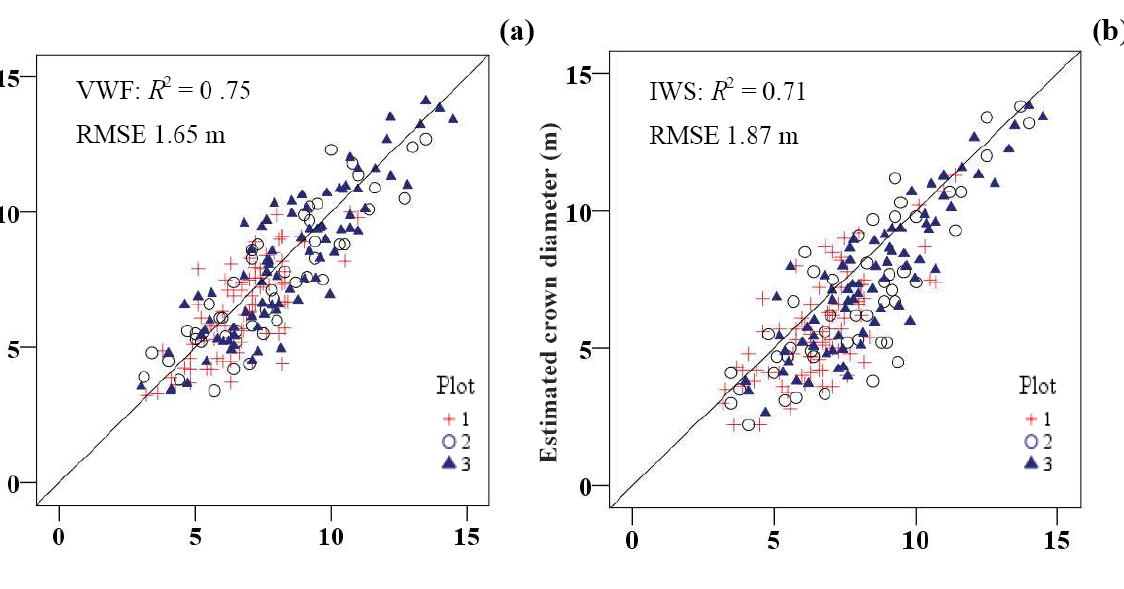
Figure 6. Field-measured crown diameter versus LiDAR-derived crown diameter using ( a ) the VWF and ( b ) IWS